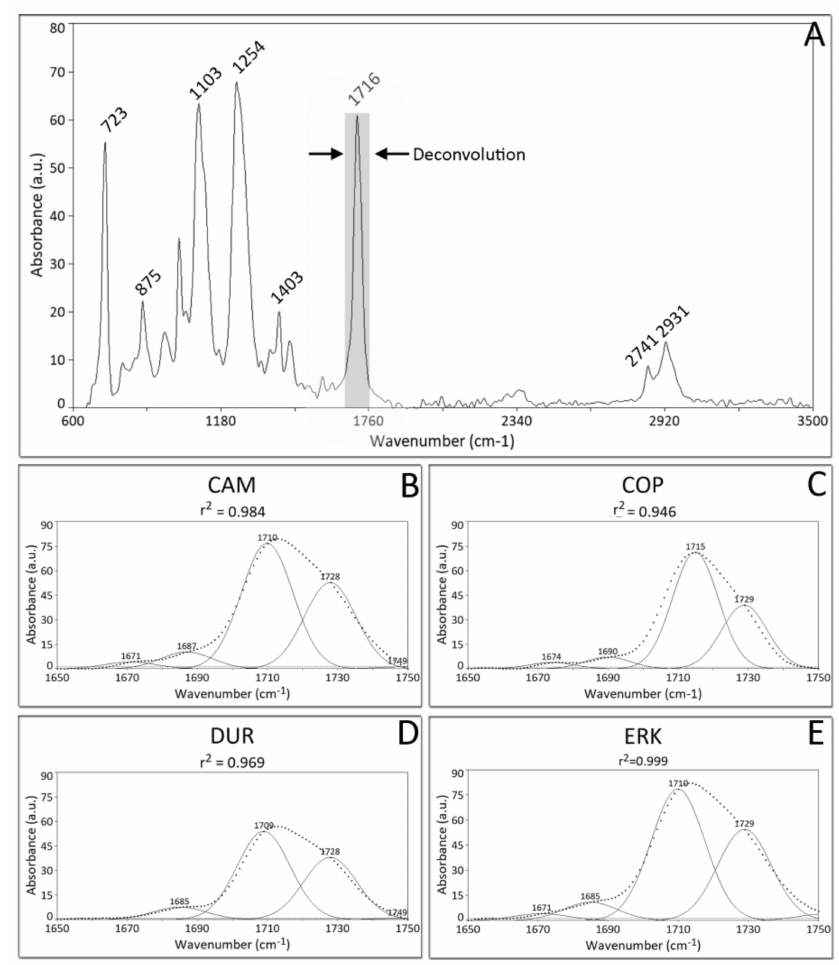
Figure 1. ( A ) Representative ATR-FTIR spectrum from all material tested. ( B – E ) Gaussian curve fitted spectra of carboxyl peak at (C = O, 1716 cm − 1 ) for CAM, COP, DUR and ERK